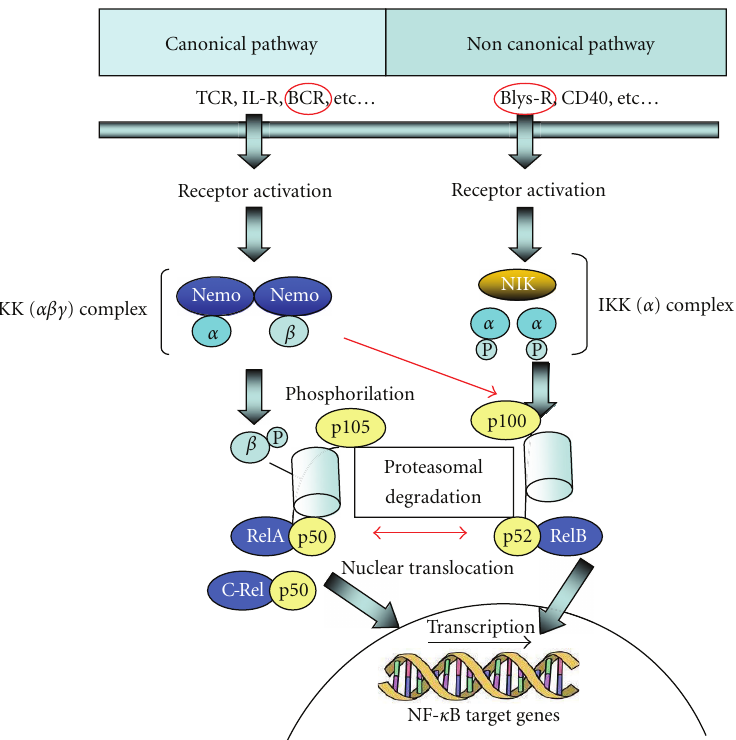
Figure 1: NF- κ B members and NF- κ B signaling. The NF- κ B family is composed of five related transcription factors: p50, p52, RelA (p65), c-Rel, and Rel-B. These transcription factors are related through homology domains in which they form homodimers and heterodimers that bind NF- κ B DNA sites, thus modulating gene expression. P50 and p52 are derived from p105 and p100 precursors, respectively. NF- κ B is silenced by interactions with inhibitory IkB family members in the cytoplasm. There are two NF- κ B signaling pathways known as the canonical pathway (or classical) and the noncanonical (or alternative) pathway. In both pathways, IkB kinase is activated and induces proteasomal degradation of the IkB inhibitor, thus allowing the translocation of the transcription factor subunits into the nucleus and induce transcription of target genes. BCR crosslinking provides the canonical NF- κ B signal and p100 production, while BLys receptor induce accumulation of p52, a protein deriving from p100 that activates NF- κ B 2 via the noncanonical